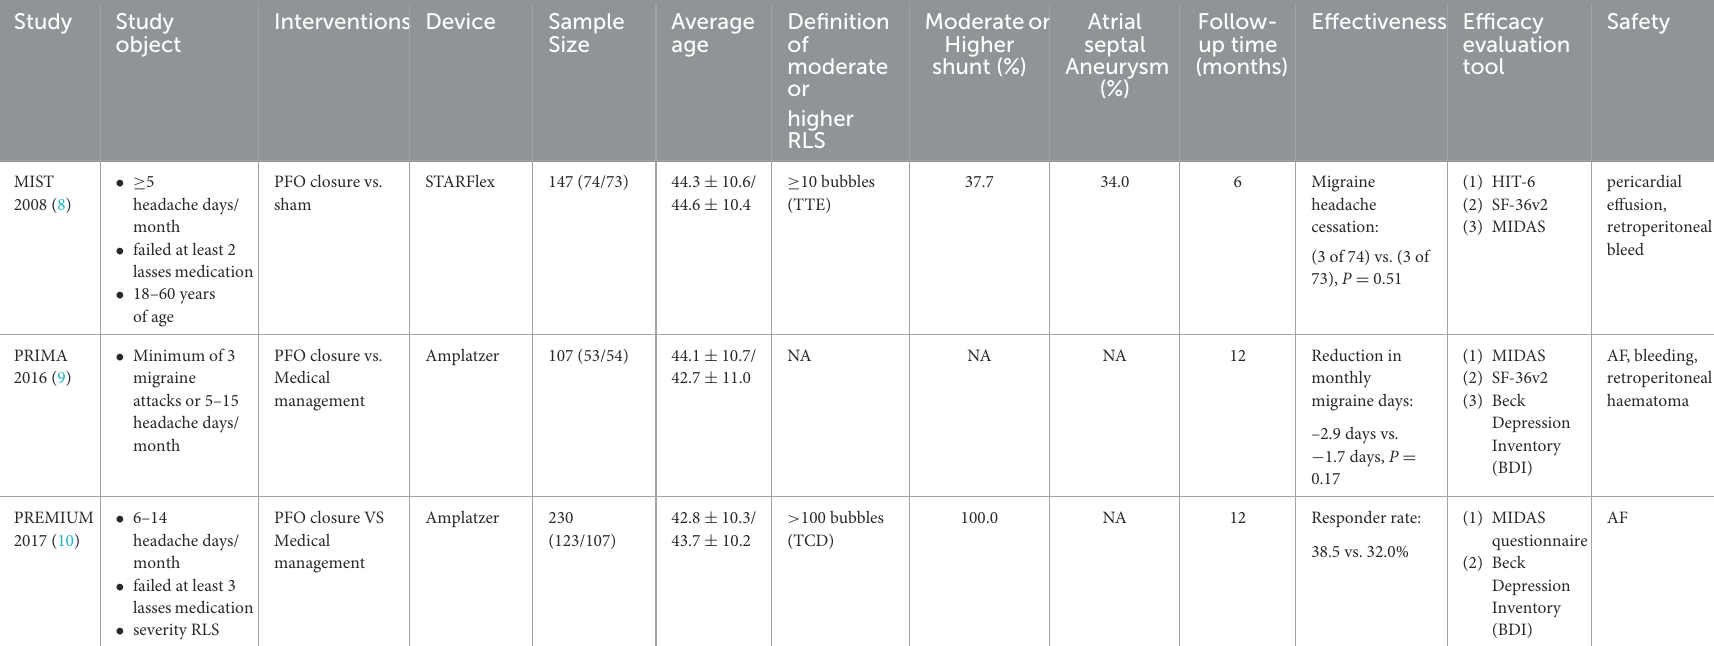
TABLE 3 Summary of important information from randomized controlled clinical trials for the treatment of PFO-related